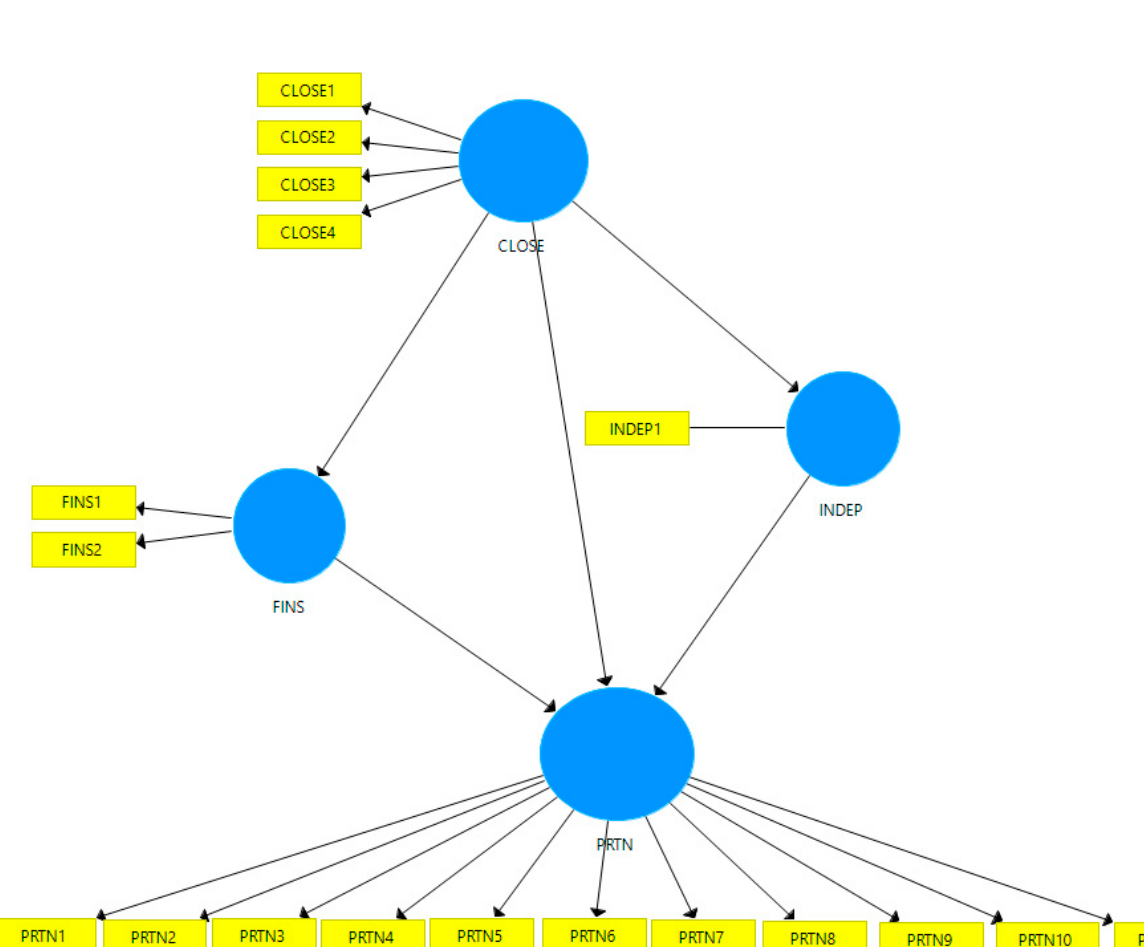
Figure 1. The path model of the research. Source: Model created by authors with SmartPLS v.3 software .